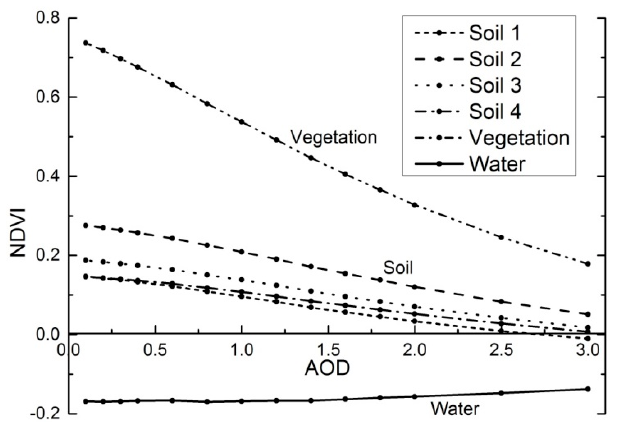
Figure 7. VIIRS true color image on 13 January 2014 ( a ) and 10 March 2014 ( b ) and the corresponding ephemeral water body test results ( c , d ) over the NCP. The ephemeral water body pixels are represented in blue.